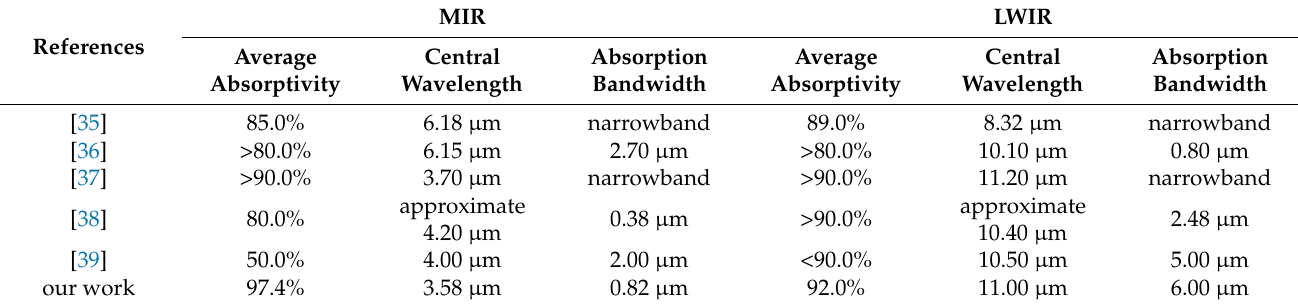
Table 2. Comparison of optical properties of representative infrared dual-band metasurfaces in recent years.